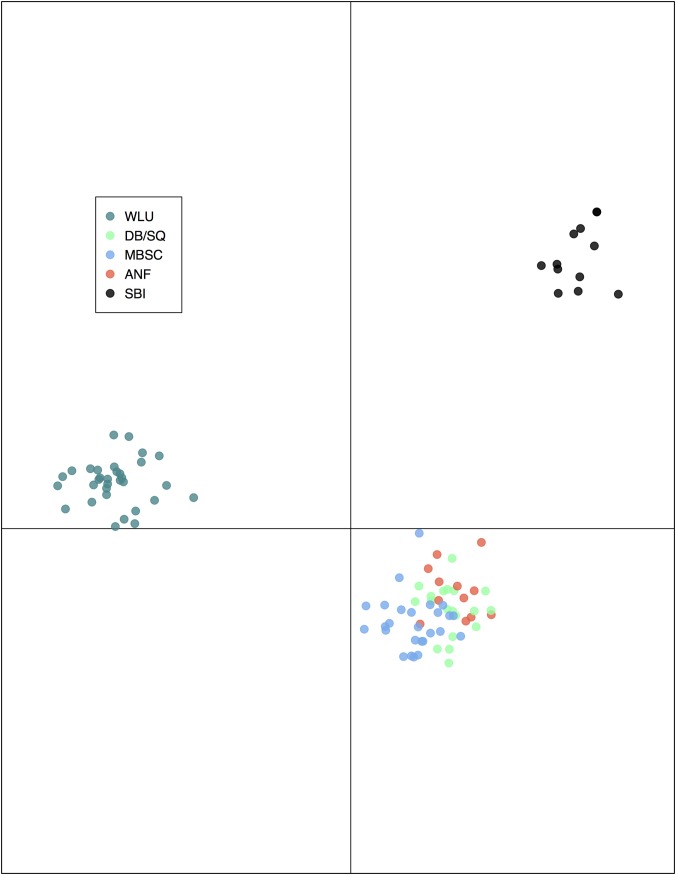
DAPC scatter plot.Scatter plot of the first two discriminant functions revealed groupings consistent with the results from STRUCTURE. The first discriminant function identifies three clusters: WLU, SBI, and mainland OH/PA. The second discriminant function further separates the three major clusters, SBI in particular, while also providing some separation within the mainland OH/PA cluster.